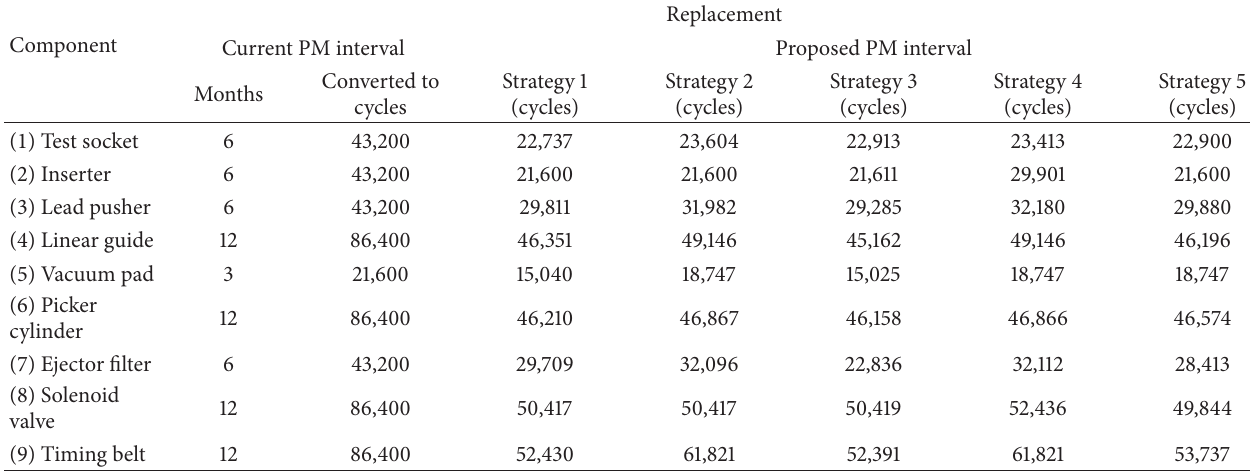
Table 13: Current and proposed PM interval for each component.